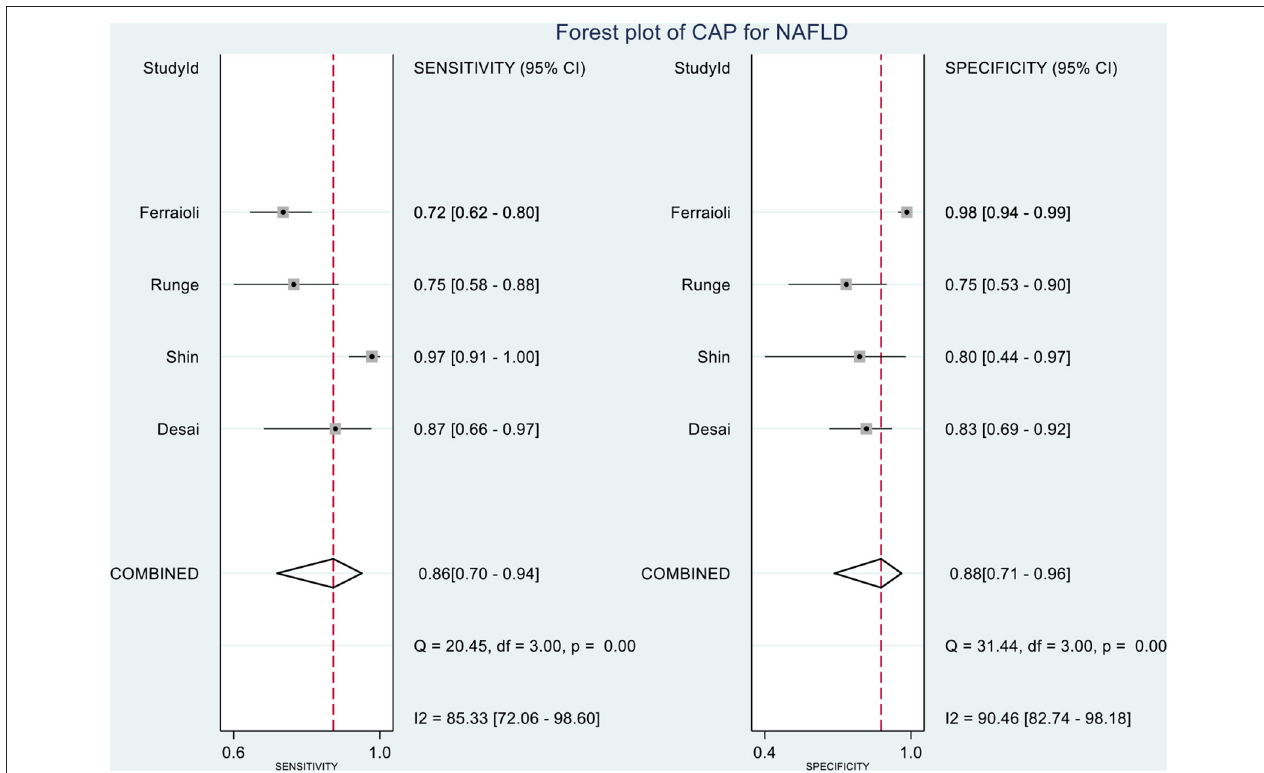
FIGURE 9 | Forest plot to evaluate the sensitivity and specificity of CAP in diagnosing NAFLD (S0 vs.